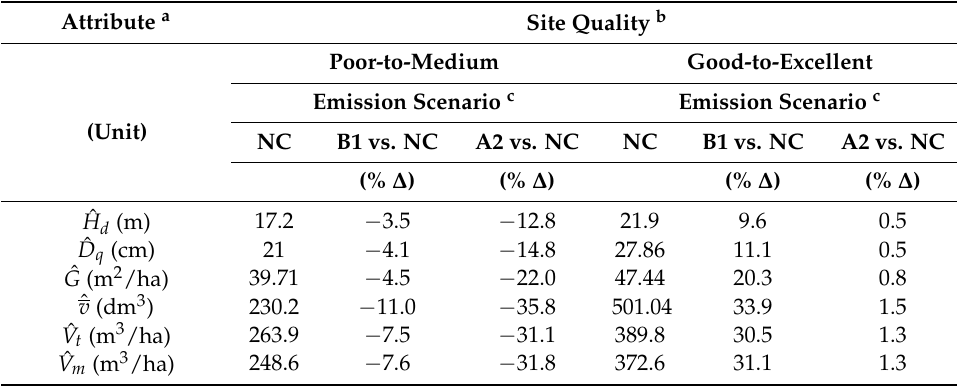
Table A1. Rotational yield estimates for black spruce plantations managed under a basic silvicultural intensity in north-eastern Ontario by emission scenario and site